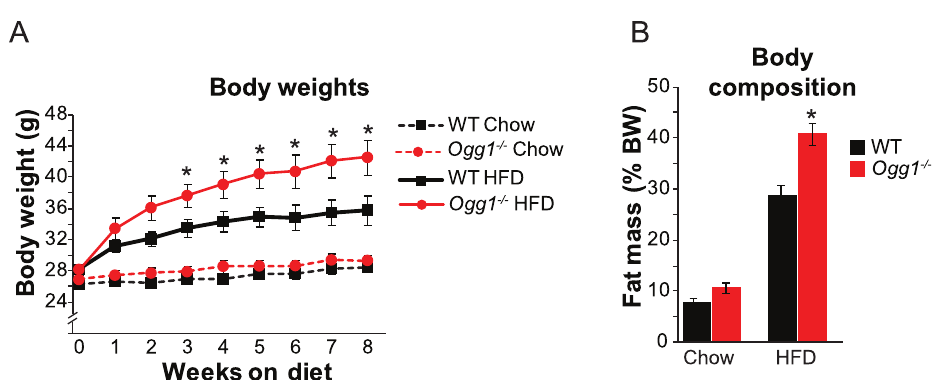
Fig 1. Body weight and composition on chow and HFD. WT and Ogg1 -/- 12-week old male mice were given ad libitum access to chow or HFD for 8 weeks. (A) Mice were weighed weekly during and (B) body composition was measured by NMR at the end of 8 weeks of feeding. n = 6 animals per cohort. � , p < 0.05 vs. WT.